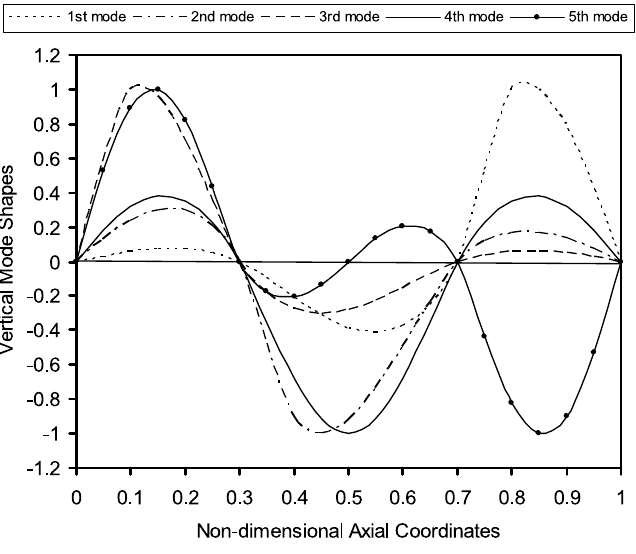
Fig. 8. The fi rst fi ve mode shapes for the model with three spring-mass systems of Reddy-Bickford beam.